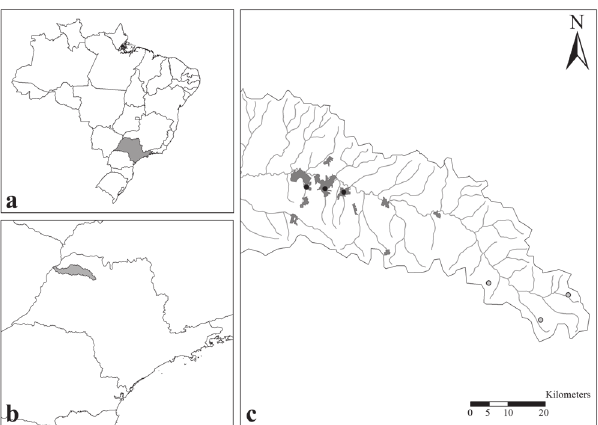
Fig. 1. Location of the study sites in the São José dos Dourados River basin, São Paulo State, Brazil ( a and b ). Forested sites (dark circles) are located within the greatest forest fragments and deforested (gray circles) streams lack arboreal vegetation in their riparian zone and are located in areas dominated by pasture ( c